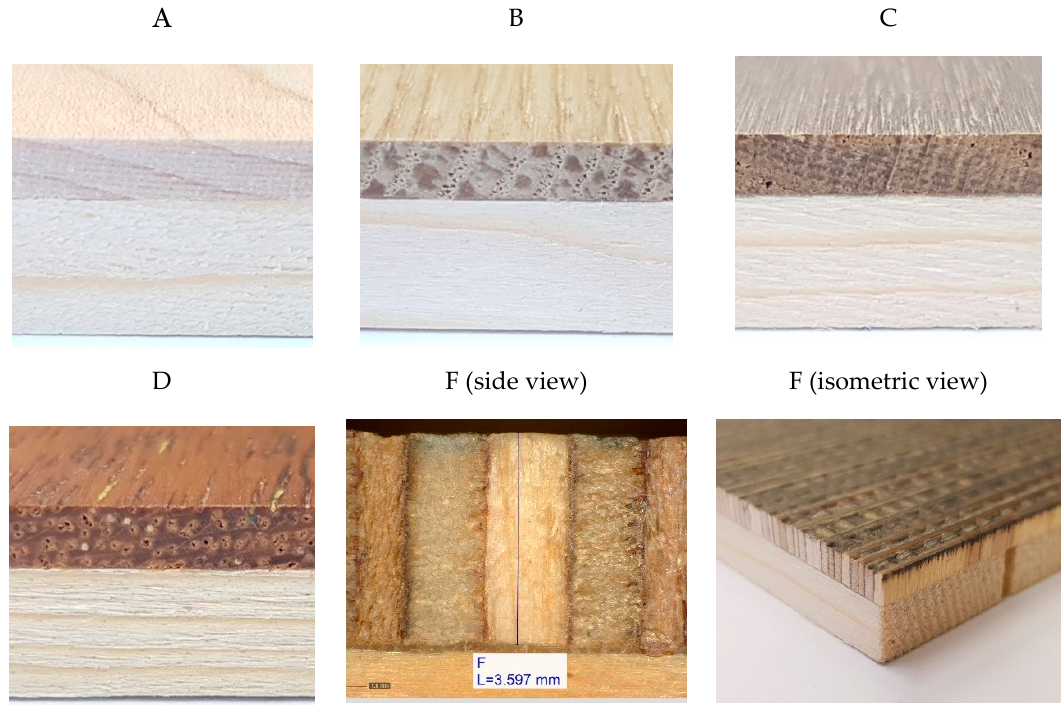
Figure 1. Two-layered test materials (markings according to Table 1, photo GP).